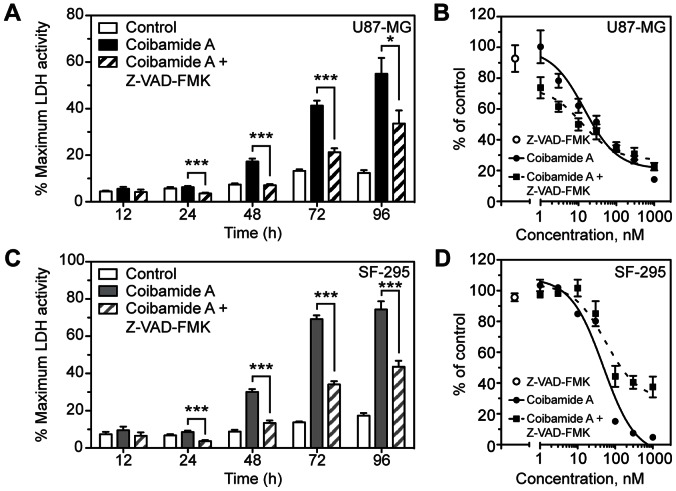
The broad-spectrum caspase inhibitor Z-VAK-FMK inhibits LDH release but does not prevent coibamide A-induced cell death.(A) Time course of LDH efflux from U87-MG cells over a 4 day exposure to coibamide A (300 nM) in the presence or absence of Z-VAD-FMK (100 µM). (B) Concentration-response relationship of coibamide A-induced cell death in the presence or absence of Z-VAD-FMK (100 µM). (C) Time course of LDH efflux and, (D) concentration-response relationship of coibamide A-induced cell death in SF-295 cells measured in the presence or absence of Z-VAD-FMK (100 µM). Histograms represent mean LDH efflux ± SE of three independent experiments performed in triplicate (**P<0.01 and ***P<0.001, coibamide A vs. control). Cytotoxicity was determined by MTT assay after 3 days of exposure to coibamide A (300 nM) with the viability of control cells defined as 100%; cell viability in the presence of Z-VAD-FMK alone (100 µM) is represented by an open circle. Dose-response data represent mean viability ± SE (n = 3 wells per treatment) from a comparison that was repeated in three independent experiments.